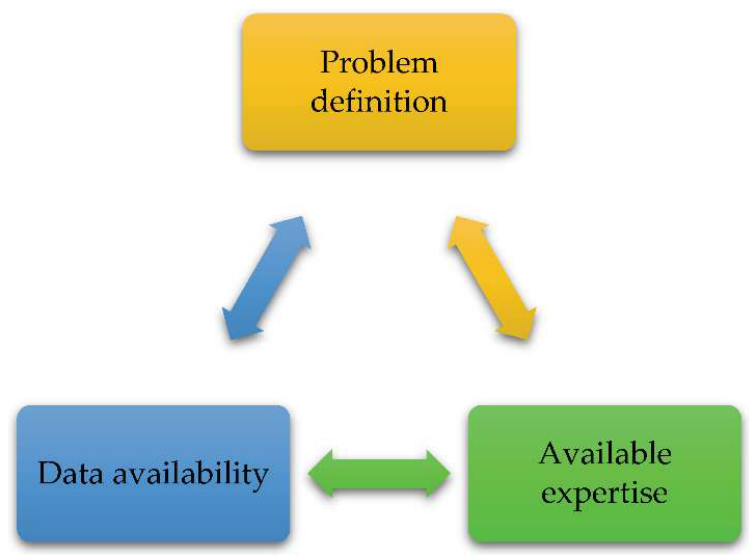
Figure 12. ML algorithm selection criteria context.